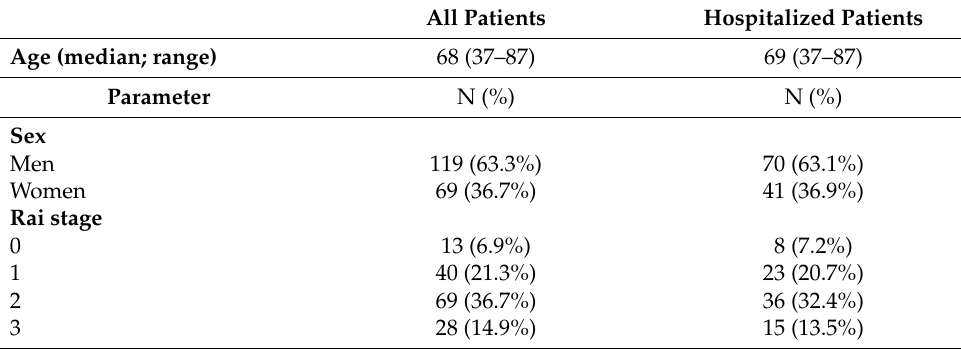
Table 1. Clinicopathological characteristics of all analyzed patients and patients requiring